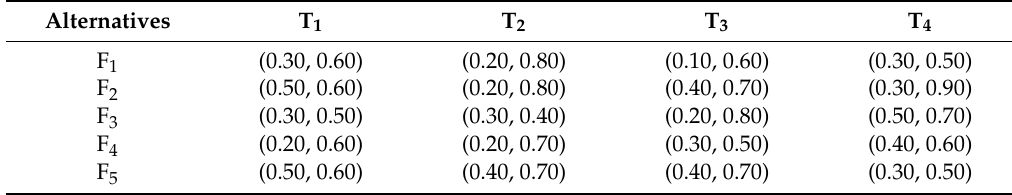
Table 3. Pythagorean fuzzy matrix by DM 3.